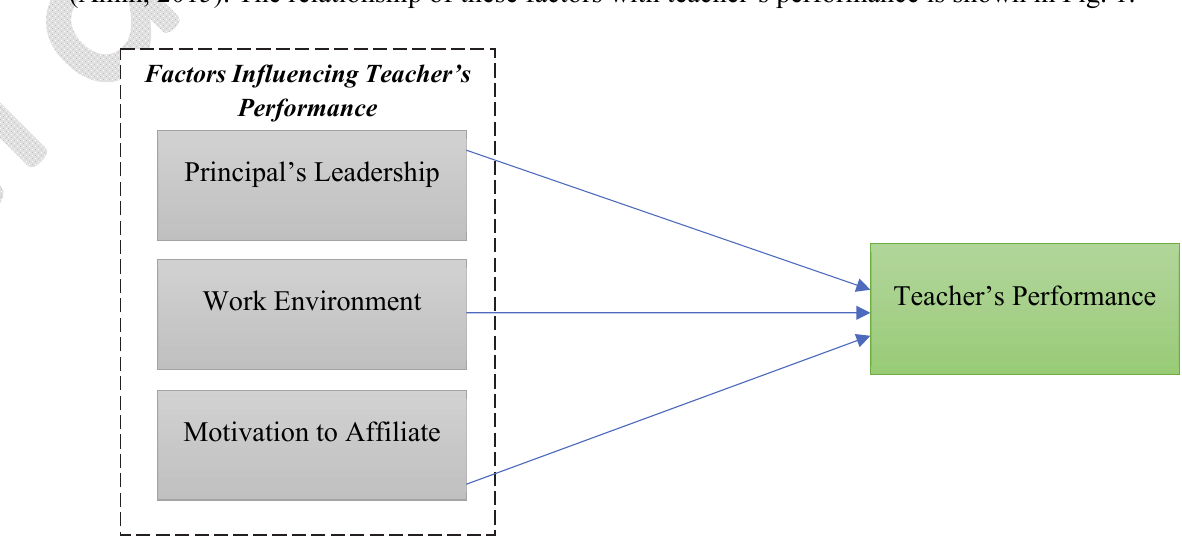
Fig. 1. Theoretical framework of the study showing the relationship between principal’s leadership, work environment, motivation to affiliate and teacher’s